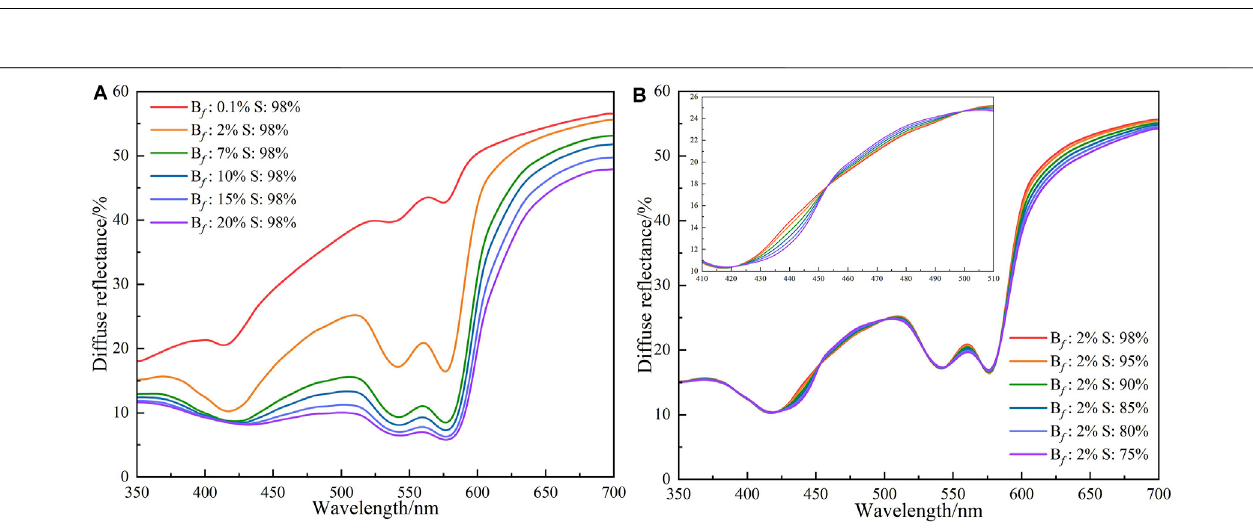
FIGURE3| Thediffusere fl ectancesofdifferentbloodvolumefractionand bloodoxygensaturation: (A) Thebloodoxygensaturationis98%,andthebloodvolume fraction is 0.1%, 2%, 7%, 10%, 15%, and 20%; (B) The blood volume fraction is 2%, and the blood oxygen saturation is 75%, 80%, 85%, 90%, 95%, and 98%.